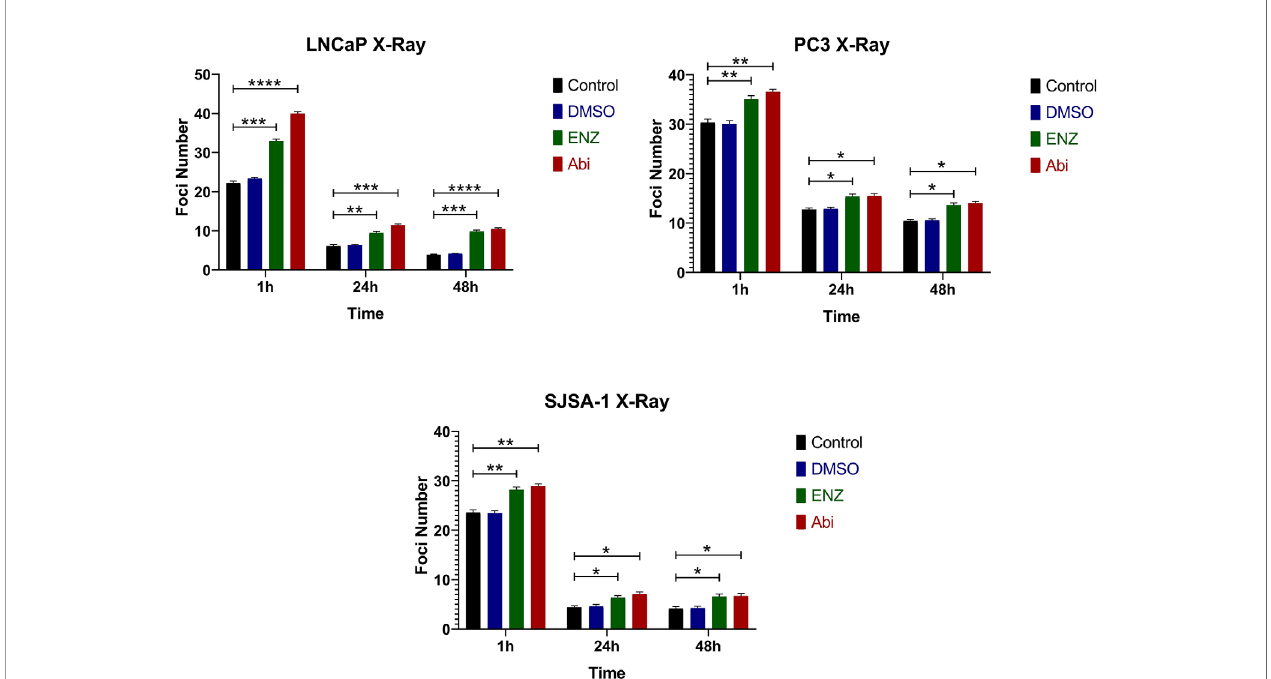
FIGURE 6 | Immuno fl uorescence of 53BP1 foci treated with Abiraterone and Enzalutamide in combination with 2 Gy X-ray in AR-insensitive PC3s and AR-sensitive LNCaP prostate models and osteoblastic bone model SJSA-1. All models were treated with 10 m M Abiraterone, Enzalutamide or DMSO 24 hours before being administered 2 Gy radiation. Samples were then harvested 1, 24- and 48-hours post-radiation before being fi xed and stained with 53BP1 (n=3). Unpaired students t-test was used for comparisons between two groups *p ≤ 0.05, **p ≤ 0.01, ***p ≤ 0.001 ****p ≤ 0.0001, and error bars represent SEM.